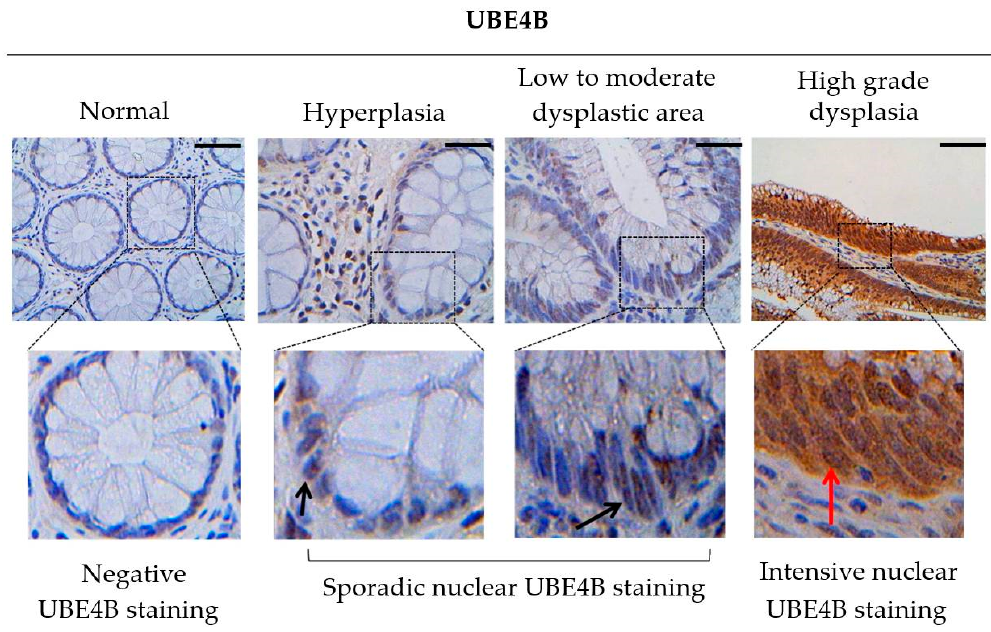
Figure 4. Comparison of UBE4B in colon pre-cancerous lesions in relation to normal areas. In hyperplasia and low to moderate dysplasia, UBE4B seems to be overexpressed sporadically in some nuclei of tubular glands of Lieberkühn (black arrows). In high grade dysplasia, the intensity of staining is higher (red arrow). Scale bar: 50 μ m.